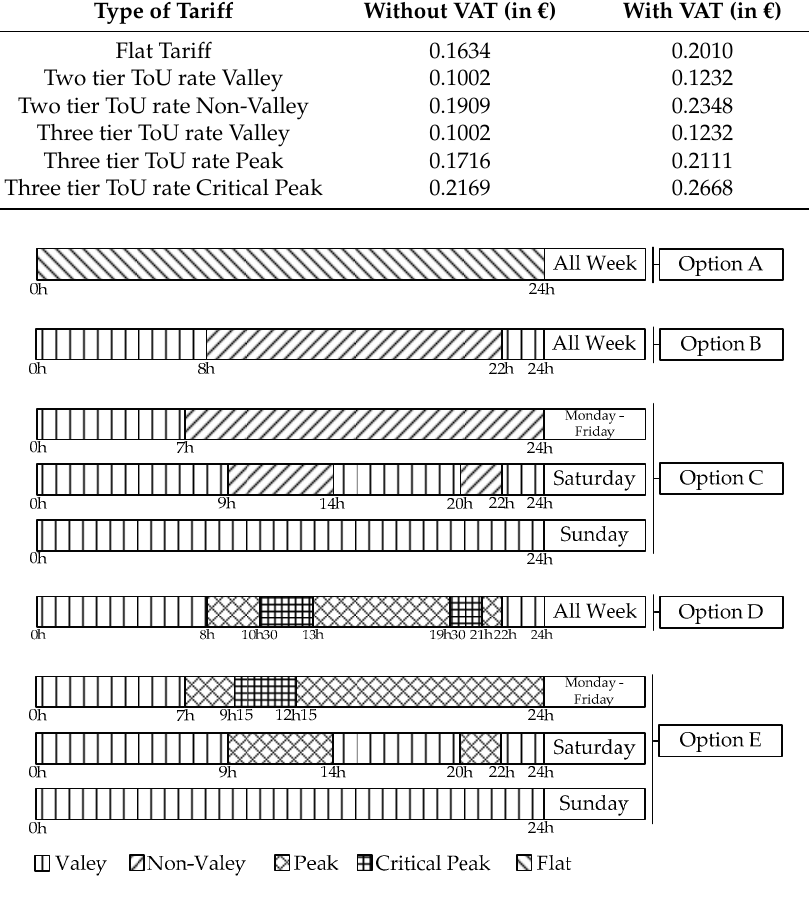
Figure 7. The options of ToU electricity rates in Portugal.